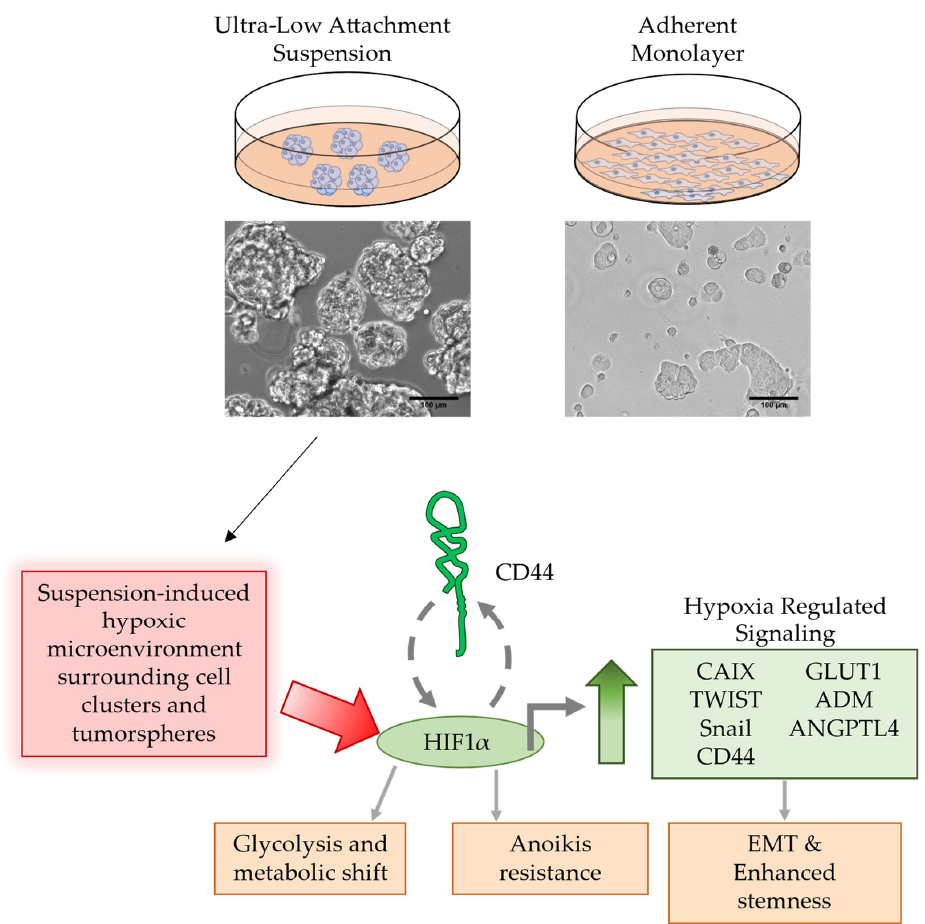
Figure 6. Suspension culture induces hypoxia-regulated signaling in tumor cell clusters and spheres. BCCs cultured in a non-adherent suspension condition may result in a hypoxic microenvironment surrounding the “circulating” tumor spheres and clusters. The activation of hypoxia-regulated signaling through HIF1 α resulted in increases in CAIX, TWIST, Snail, and GLUT1 expression, which are known EMT factors that result in enhanced stemness of the BCSC. CD44 and HIF1 act in a positive feedback loop through PI3K/AKT signaling, resulting in sustained CD44 + cells through the 7 days of culture. CAIX is a potential marker that may be used to monitor or act as a therapeutic target for hypoxia ‐ enriched cCSCs.